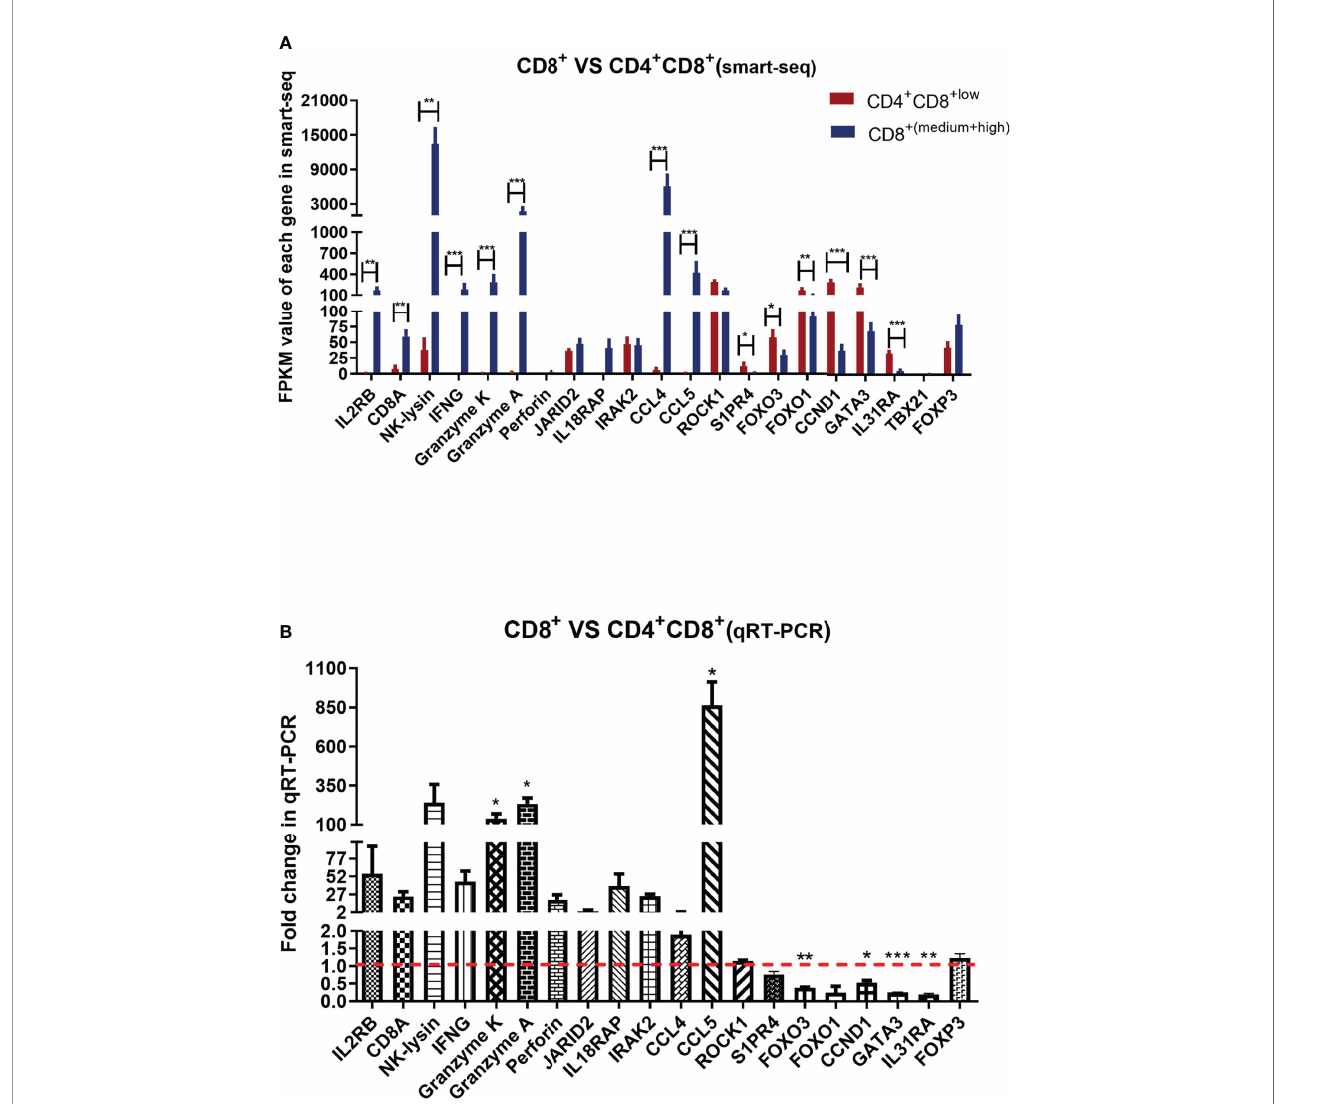
FIGURE 5 | Analysis of the selected gene expressions in CD8 + T cell compared to CD4 + CD8 low+ double-positive T cell by smart-seq and qRT-PCR. (A) Analysis expression of randomly selected 21 DEGs in CD4 + CD8 low+ T cells and CD8 + T cells (containing CD8 medium+ and CD8 high+ T cells) of ALV-J infected chickens by smart-seq. The data shown are mean ± SE (n=4 in CD4 + CD8 low+ T cells, and n=8 in CD8 + T cells). (B) Analysis expression of 20 DEGs in CD8 + T cells compared to CD4 + CD8 + T cells by qRT-PCR. Total RNA of sorted CD8 + T cells and CD4 + CD8 low+ double-positive T cells were extracted from three ALV-J infected chickens. The data was collected from three biological samples, and each sample was tested in triplicate. The results are presented as means ± SEM. Statistical comparisons were performed using GraphPad Prism. Statistical signi fi cance was assessed at P -values * P < 0.05, ** P < 0.01, *** P <